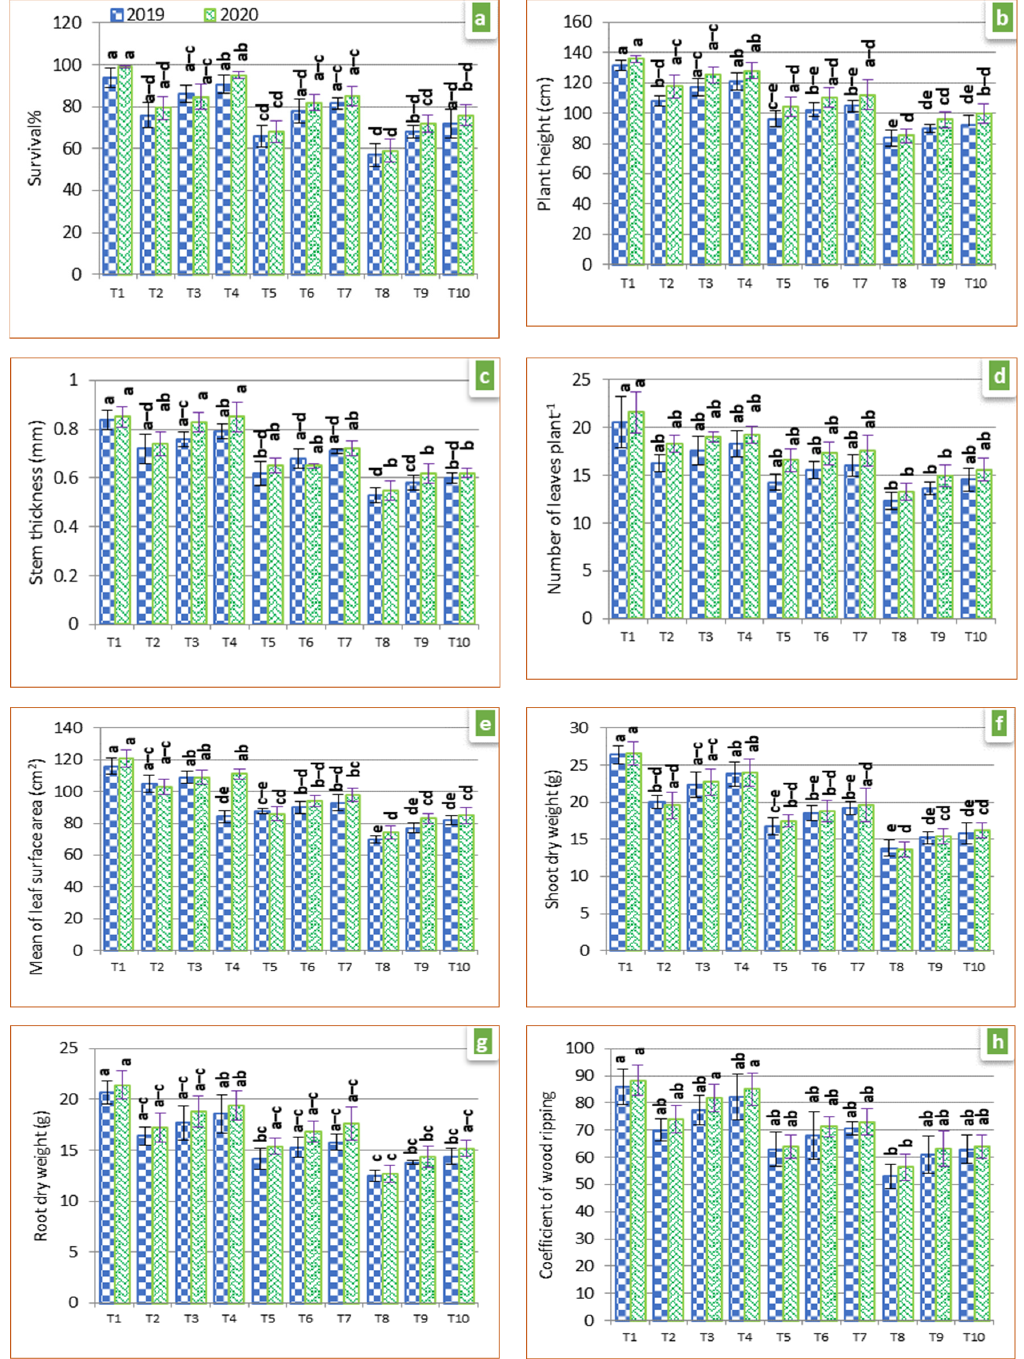
Figure 6. Plant growth trials ( a – h ) of grapevine seedling as affected by salinity (NaCl) and brassinolide (BL) during both growing seasons. Data represent the average of five replicates ± standard error. Different letters in each column indicate significant ( p ≤ 0.05) differences at p ≤ 0.05 according to Tukey’s HSD range at p ≤ 0.05. (T1, 0 NaCl without BL application; T2, 1000 mg L − 1 NaCl without BL application; T3, 1000 mg L − 1 NaCl with 1 mg L − 1 BL application; T4, 1000 mg L − 1 NaCl with 2 mg L − 1 BL application; T5, 2000 mg L − 1 NaCl without BL application; T6, 2000 mg L − 1 NaCl with 1 mg L − 1 BL application; T7, 2000 mg L − 1 NaCl with 2 mg L − 1 BL application; T8, 3000 mg L − 1 NaCl without BL application; T9, 3000 mg L − 1 NaCl with 1 mg L − 1 BL application; T10, 3000 mg L − 1 NaCl with 2 mg L − 1 BL application).